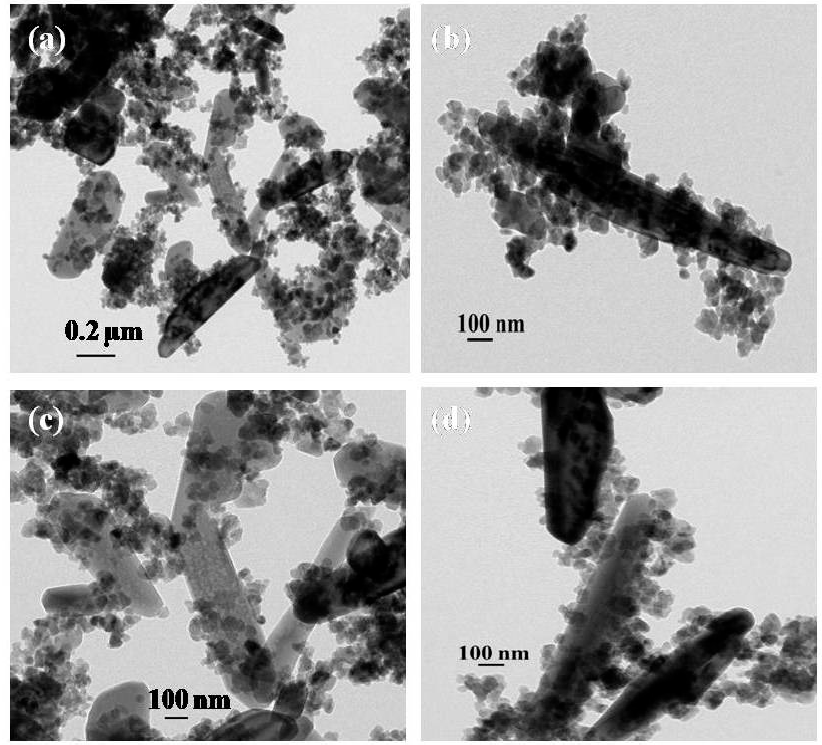
Figure 3. ( a – d ) Typical TEM images of prepared MoS 2 -ZnO heterostructure nanorods.